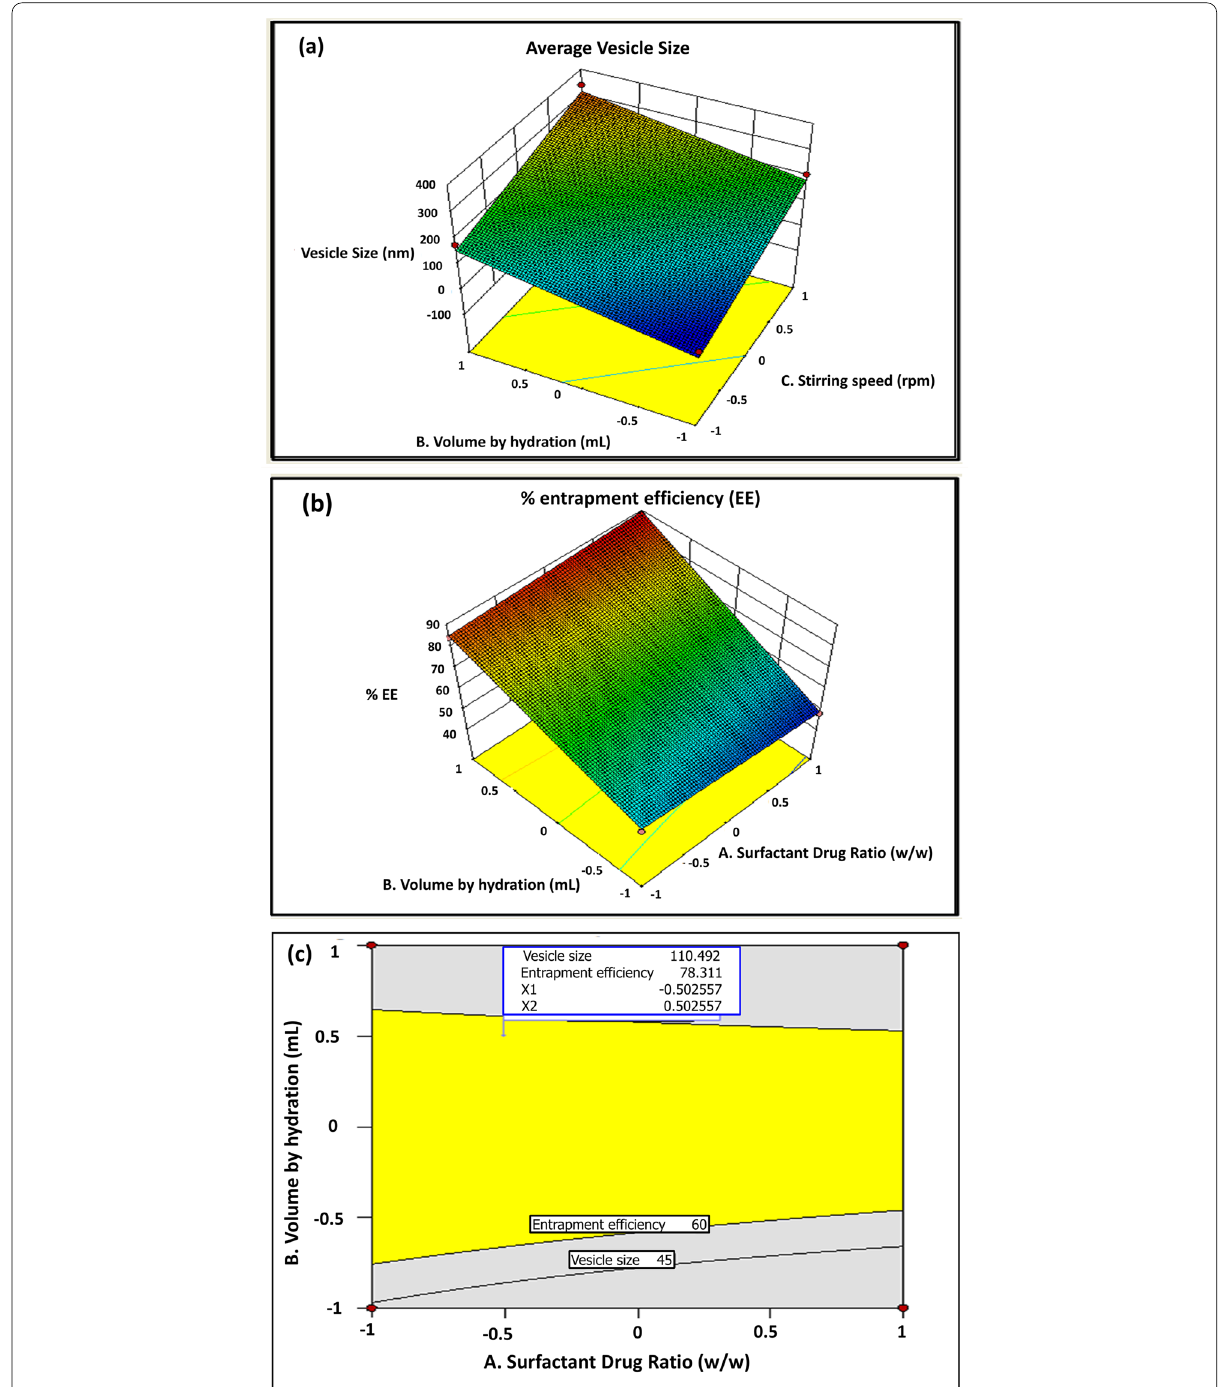
Fig. 1 a Response surface plots for average vesicle size, b response surface plots for % entrapment efficiency, and c overlay plot showing design